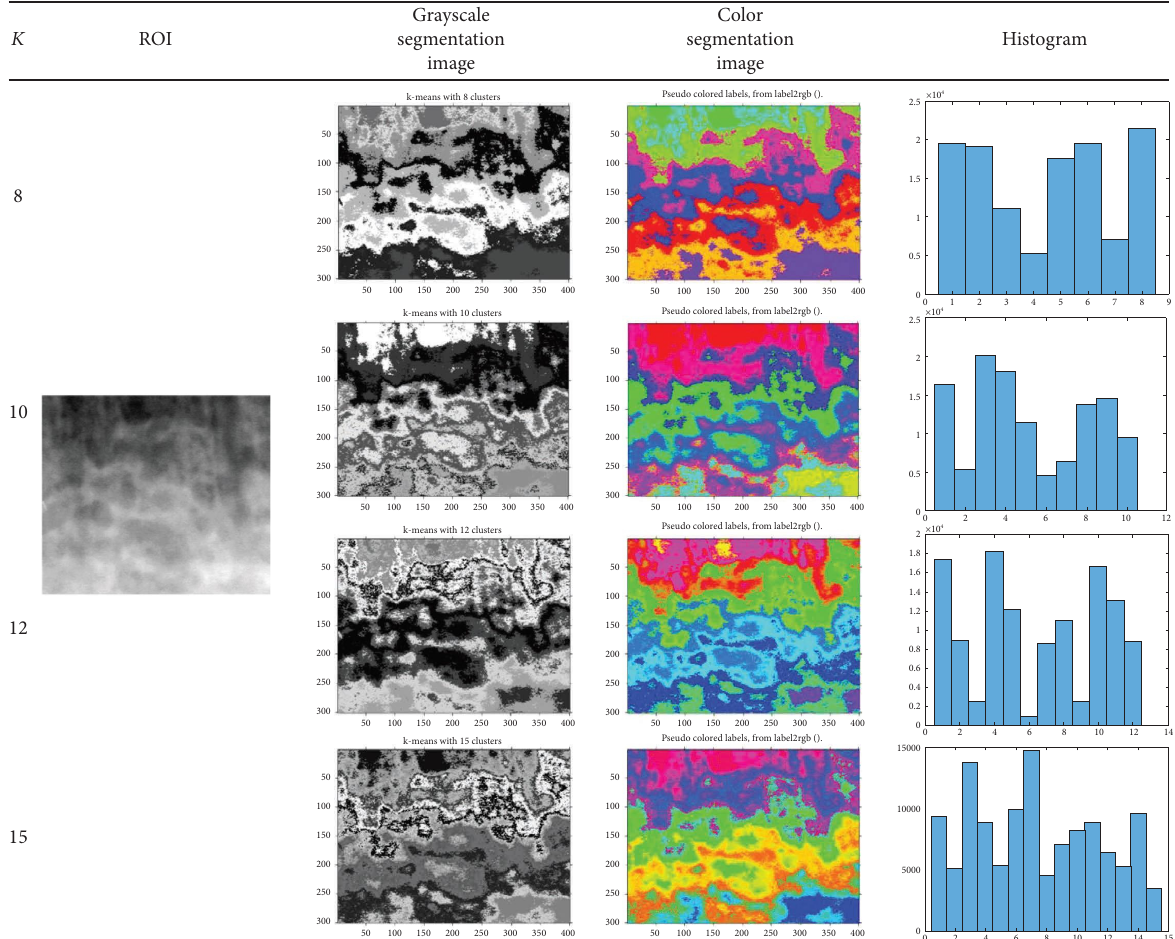
Table 1: Te results of segmentation using K -